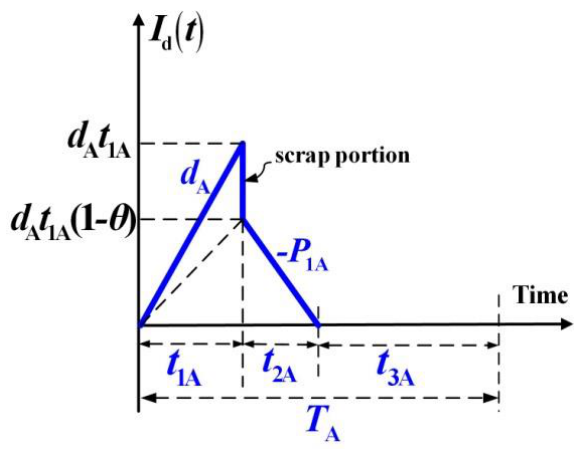
Figure 2. Status of on-hand imperfect items in the proposed system